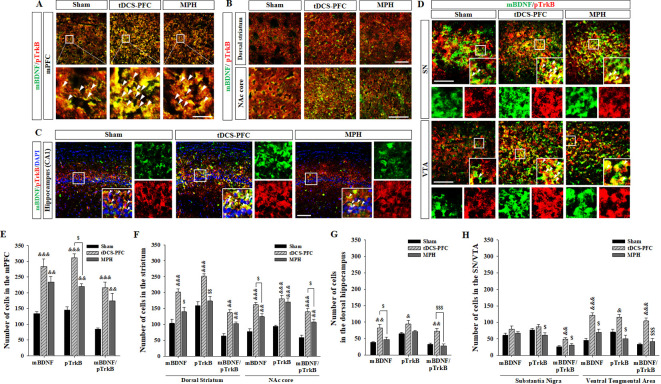
Effects of HD-tDCS application over the prefrontal cortex on mBDNF- and pTrkB-positive cells in our rat model of ADHD.(A, E) Photomicrograph and histogram showing the mean number of mBDNF- and pTrkB-positive cells in the medial prefrontal cortex, (B, F) in the striatum, (C, G) in the dorsal hippocampus, and (D, H) in the SN/VTA. The mBDNF- and pTrkB-positive cells were significantly increased in the tDCS-PFC group compared to the sham animals at all sites except the SN. Significantly more mBDNF/pTrkB double-positive cells were also detected in the SN. Data are presented as the mean ± SEM. &p<0.05, &&p<0.01 and &&&p<0.001 vs. sham; $p<0.05, $$p<0.01 and $$$p<0.001 vs. tDCS-PFC. Scale bar = 100 µm.Figure 4—source data 1.Source files for quantification of BDNF and its activated receptor.This file contains all source data for BDNF and its activated receptor shown in Figure 4.